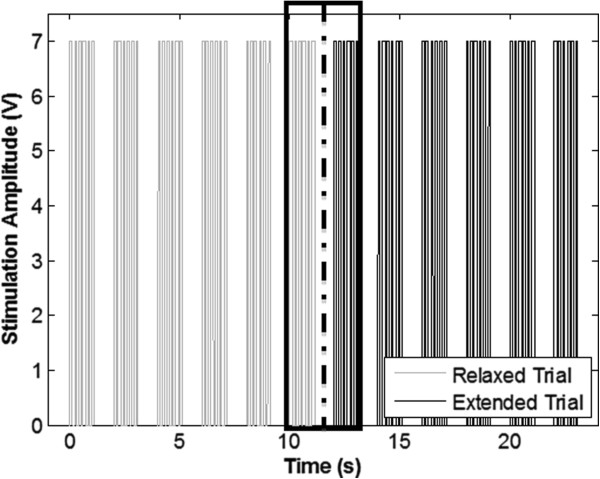
Plot of stimulation sets used in studying response latency. Stimulations were set in 5 trains of 6 stimulations for each position. The dotted line represents the point at which the knee was rotated from flexed to extended and vice versa. The boxed trains represent the trains used for calculations. These trains were chosen to eliminate time dependent factors in response amplitude caused by fatigue.